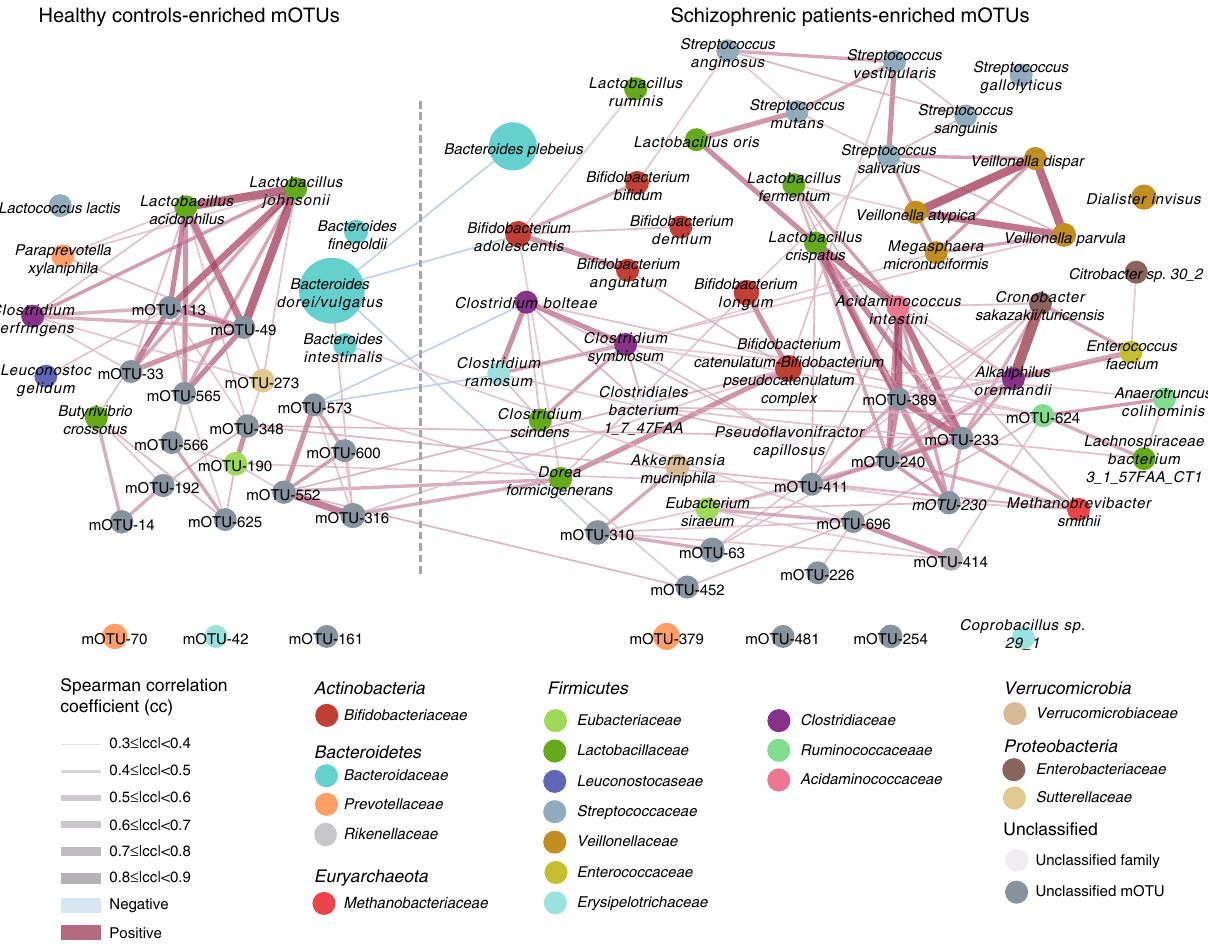
Fig. 1 Network of mOTUs differentially enriched in healthy controls and schizophrenic patients. Node sizes re fl ect the mean abundance of signi fi cant mOTUs. mOTUs annotated to species are colored according to family (Red edges, Spearman ’ s rank correlation coef fi cient > 0.3, P < 0.05; blue edges, Spearman ’ s rank correlation coef fi cient < − 0.3, P < 0.05;). See detailed statistical data in supplementary Source Data fi